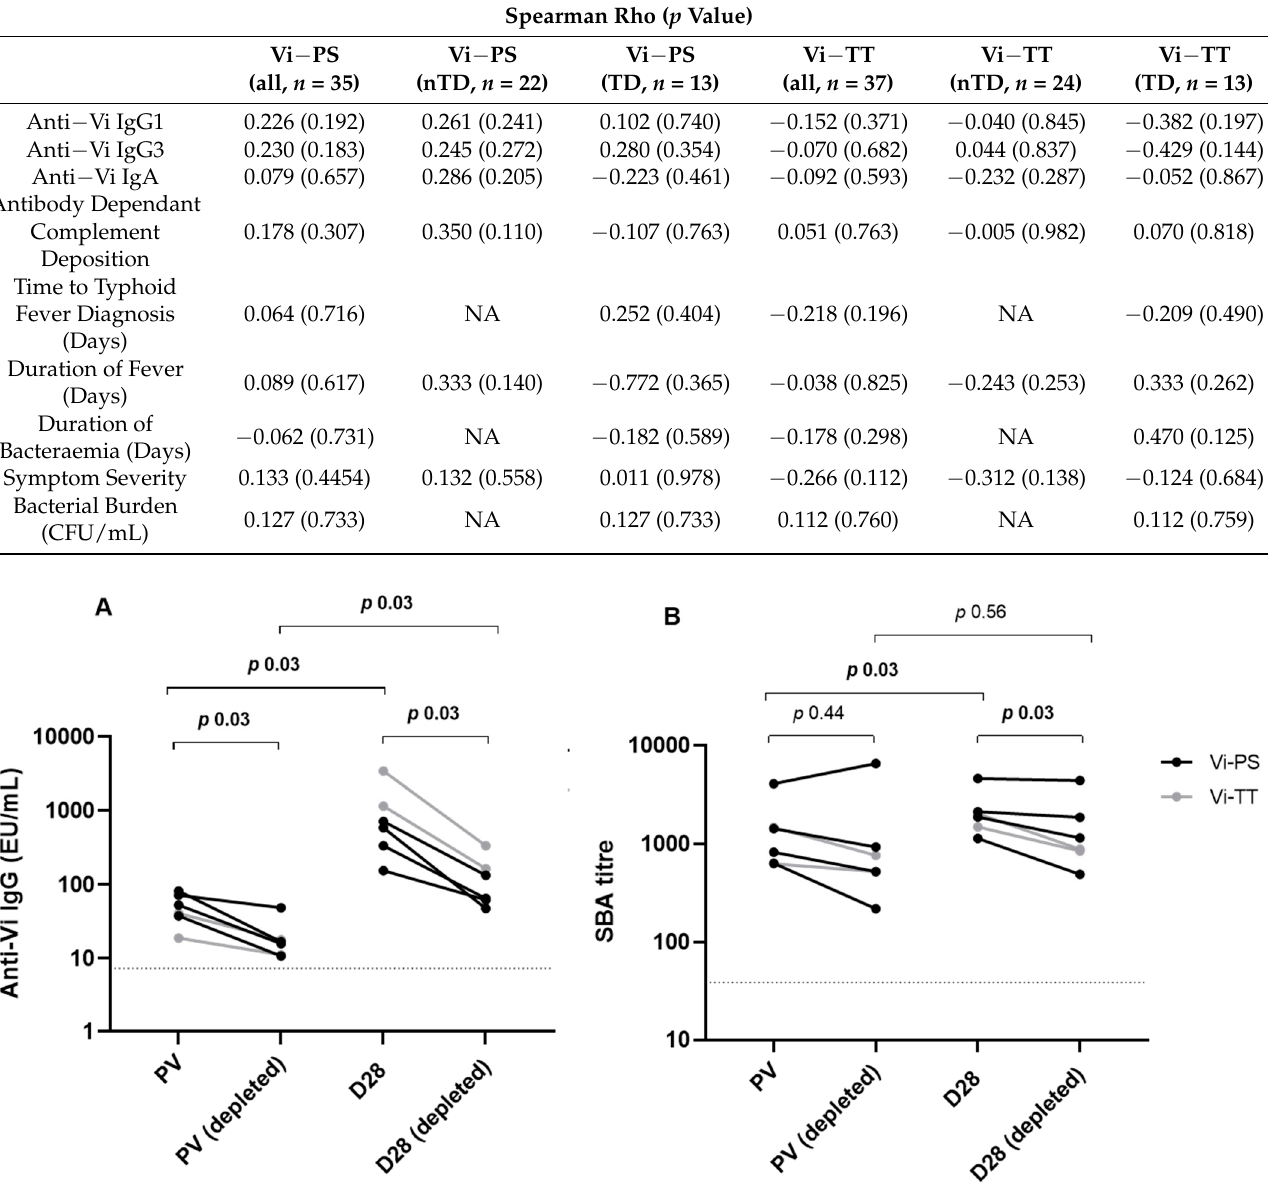
Table 1. Table of correlation outcomes of log 10 SBA titre 28 days after vaccination compared with various parameters. Anti-Vi antibody levels and antibody dependent complement deposition data all 28 days post vaccination, at the point of challenge.